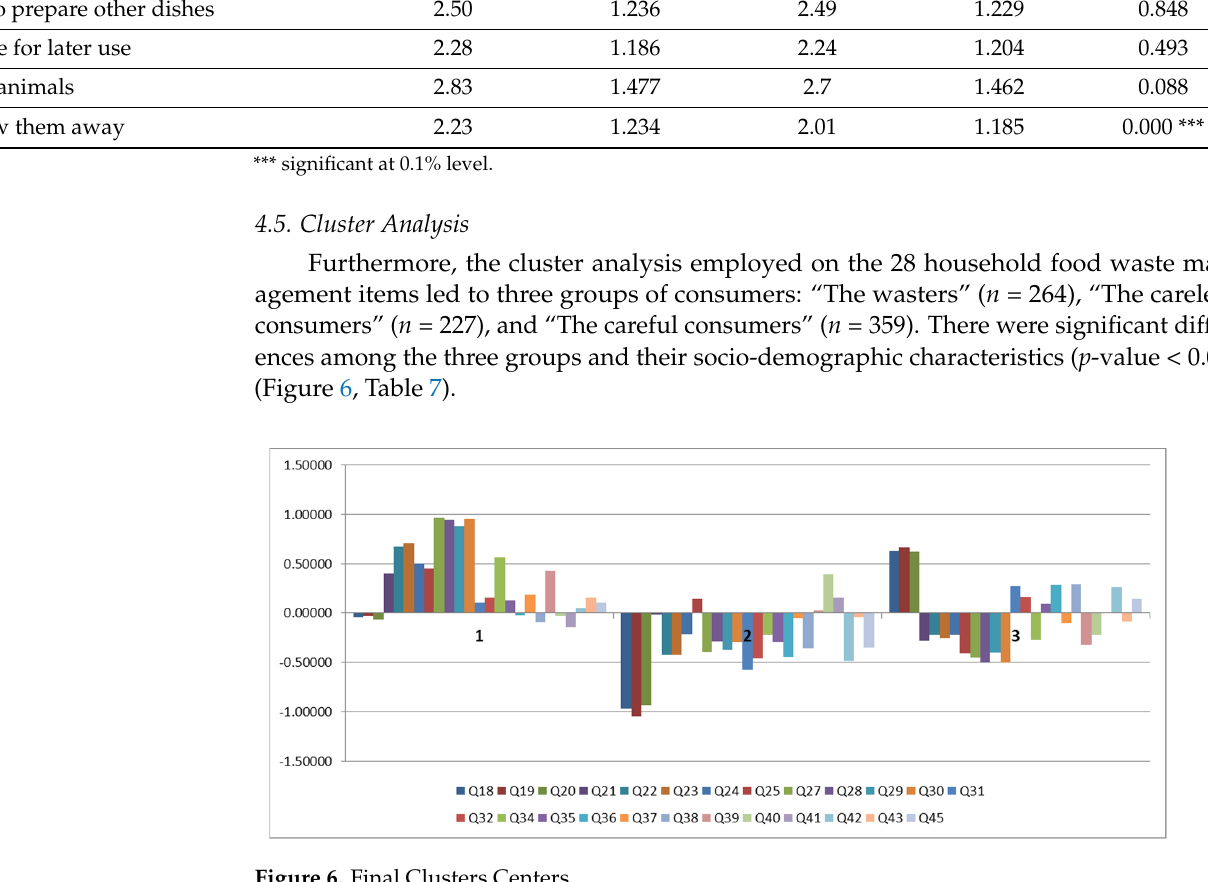
Figure 6. Final Clusters Centers. Table 7. Comparative analysis of the Clusters.